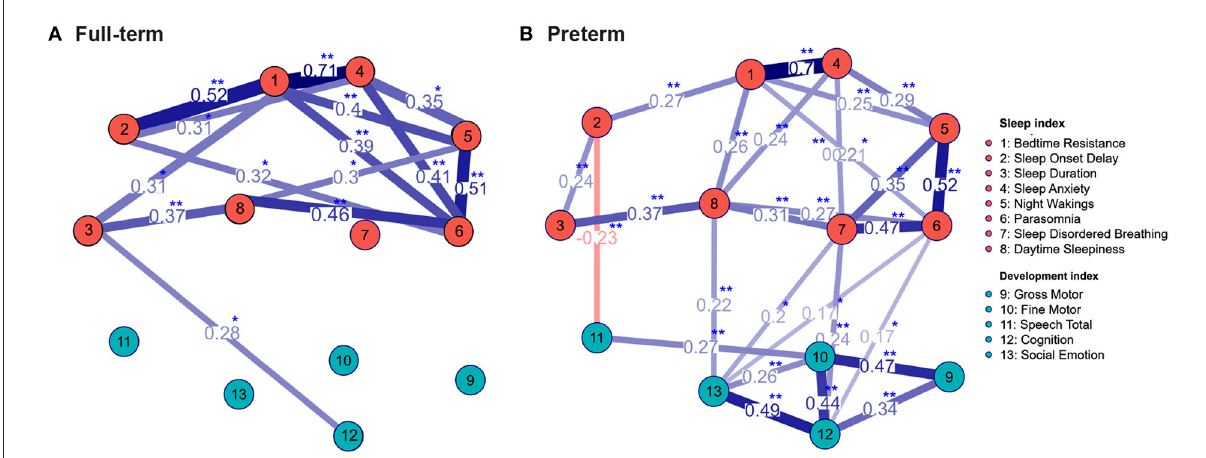
FIGURE3 The community network structure of sleep problems and neurodevelopment status in the full-term (A) and preterm (B) group. The correlation coefficients between total 13 indexes with significant interactions were labeled. Significant interactions between sleep problems and neurodevelopmental status were mostly noted in the preterm group. * p < 0.05; ** p < 0.01 using Spearman correlation